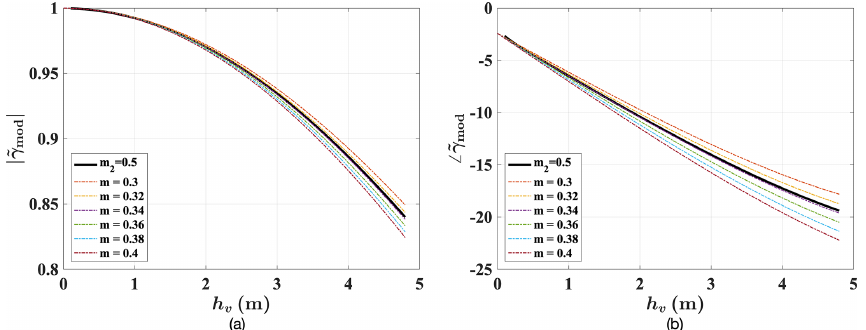
Figure 10. Comparison of complex coherence ˜ γ mod from the theoretical model ( ˜ γ mod_T , thick black line) and the simplified model ( ˜ γ mod_S , colored lines). (a) Magnitude of the modeled coherence. (b) Phase ( ◦ ) of the modeled